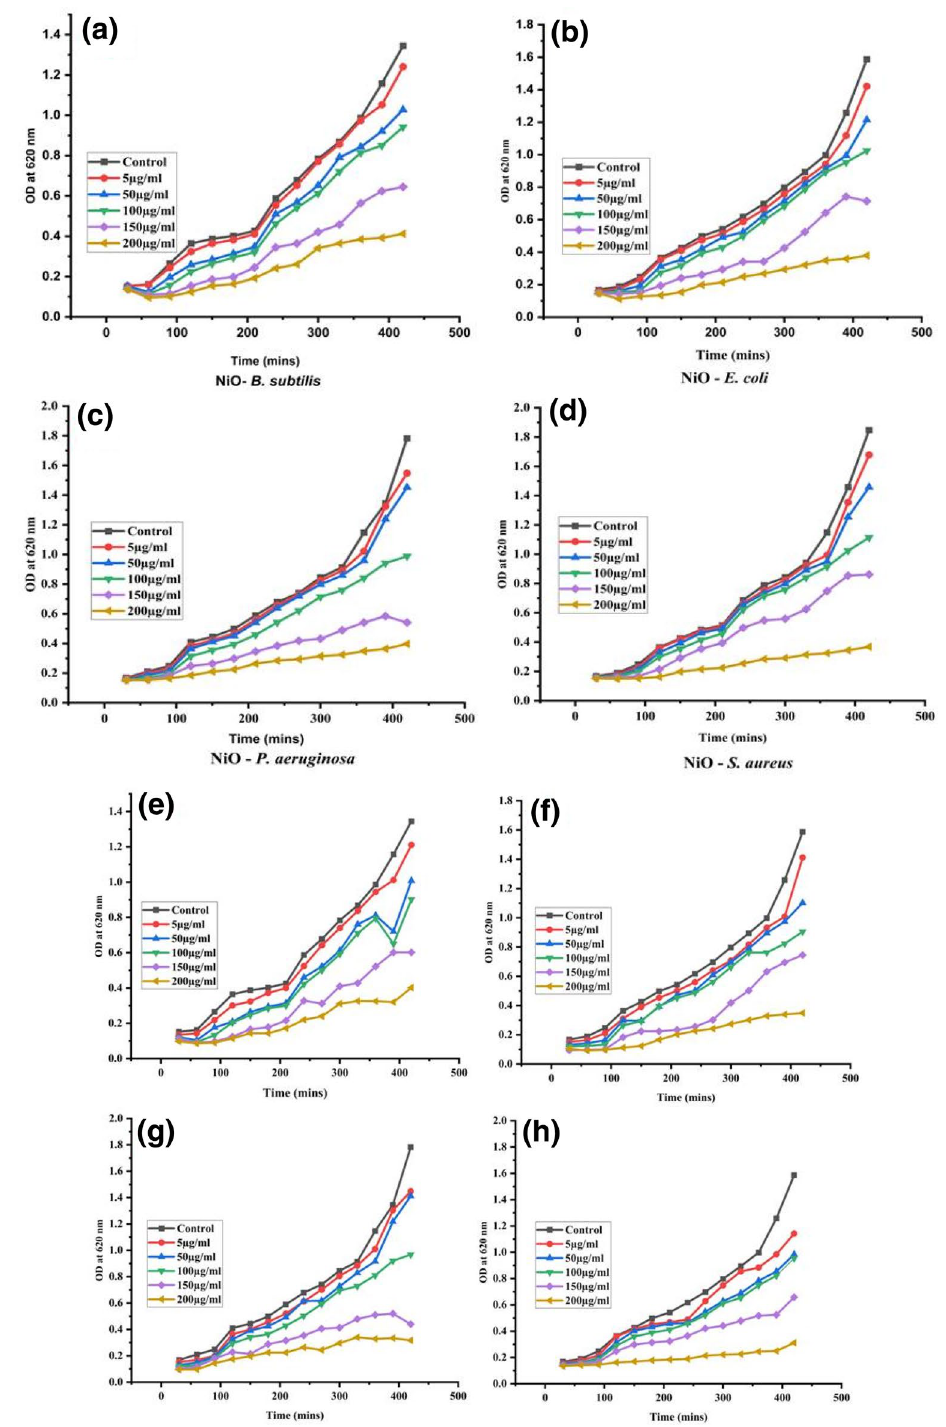
Figure 9. Effect of NiO NPs ( a – d ) and Mo doped NiO ( e – h ) on growth kinetics of B. subtilis , E. coli , P. aeruginosa and S. aureus